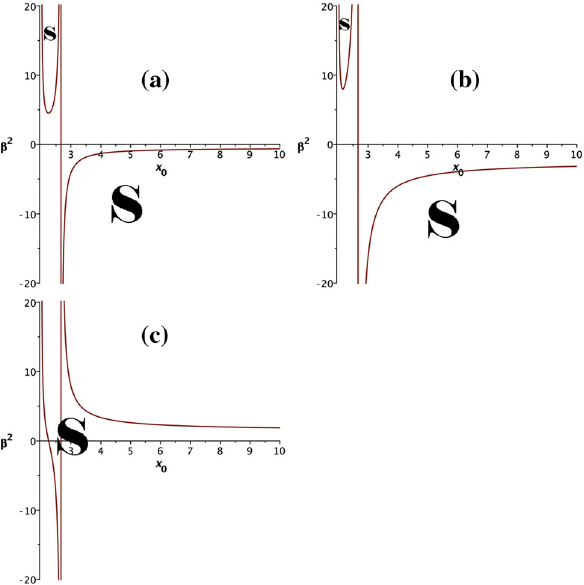
Fig. 9 For an S–ERN ATSW, the plot of β 2 against x 0 are compared for the cases a γ a = 0, b γ b = − 1 /π M 2 x 2